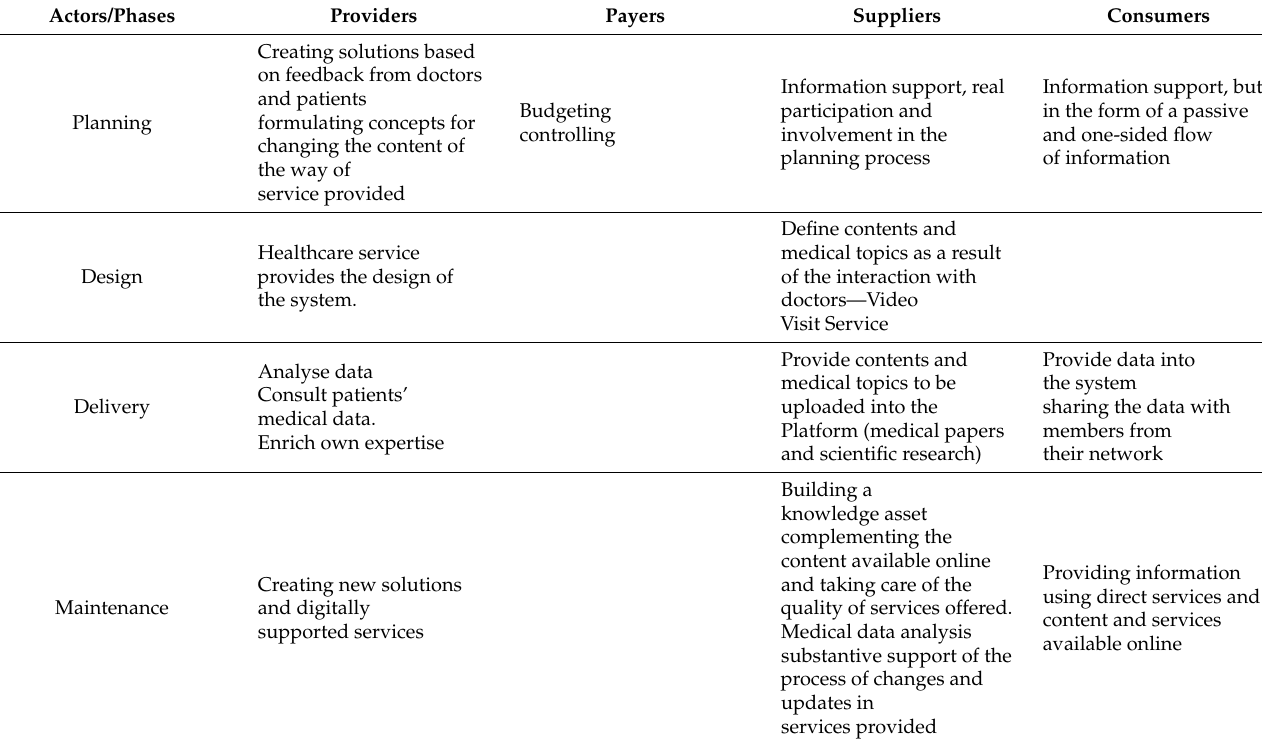
Table 5. Cocreation matrix for digital health